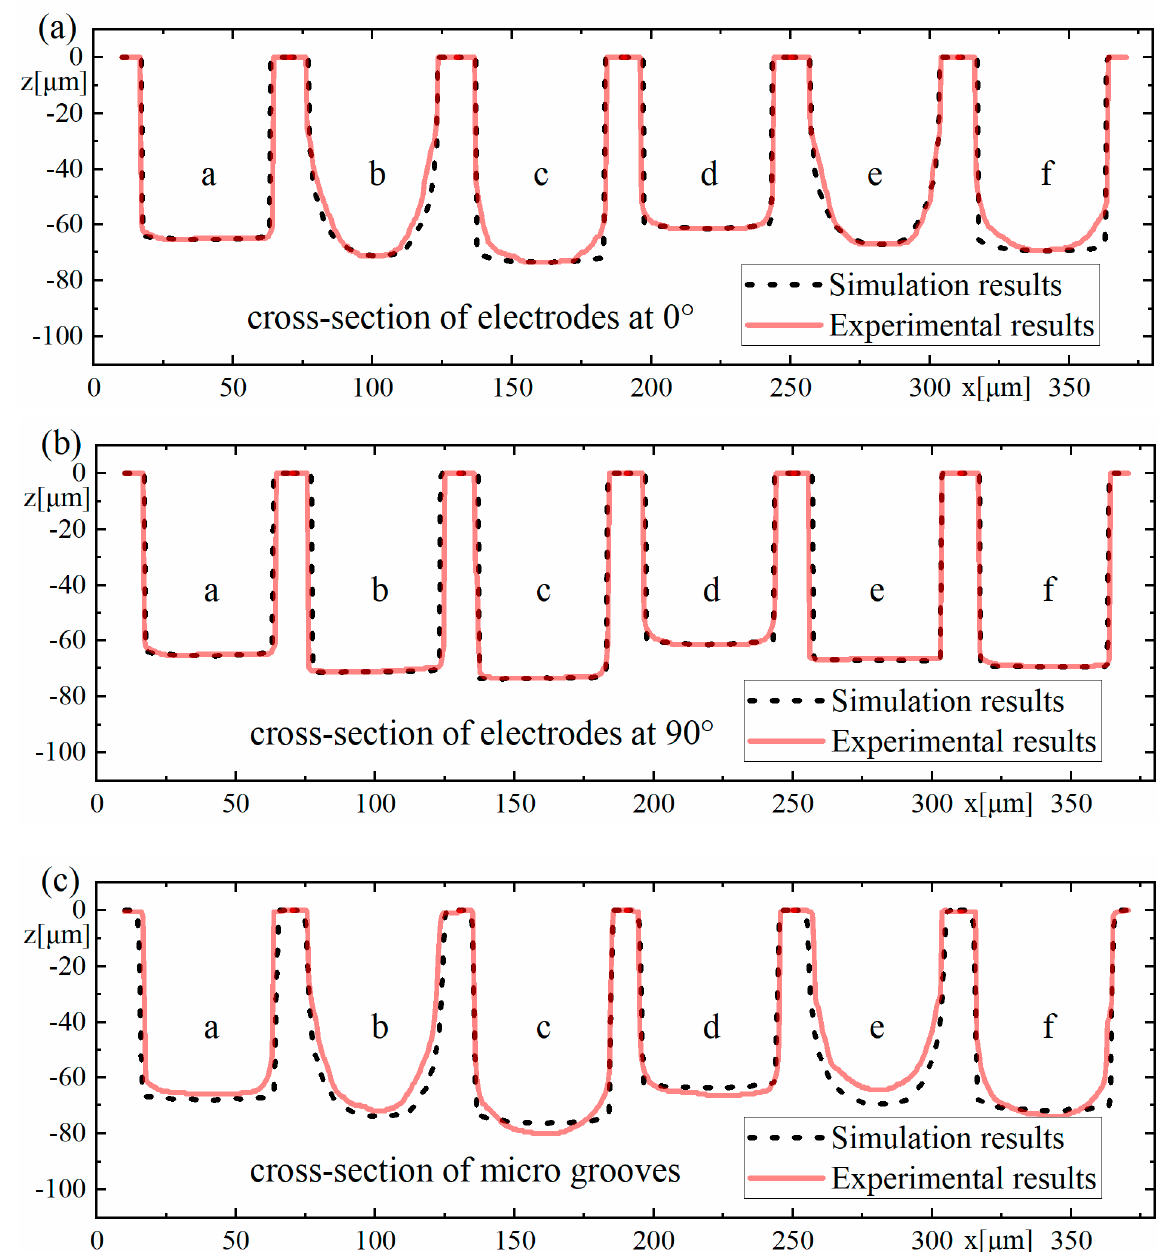
Figure 18. Comparison of the experimental results for Exp. 1 and the simulation results: ( a ) cross-section of electrodes at 0°, ( b ) cross-section of electrodes at 90°, and ( c ) cross-section of microgrooves.